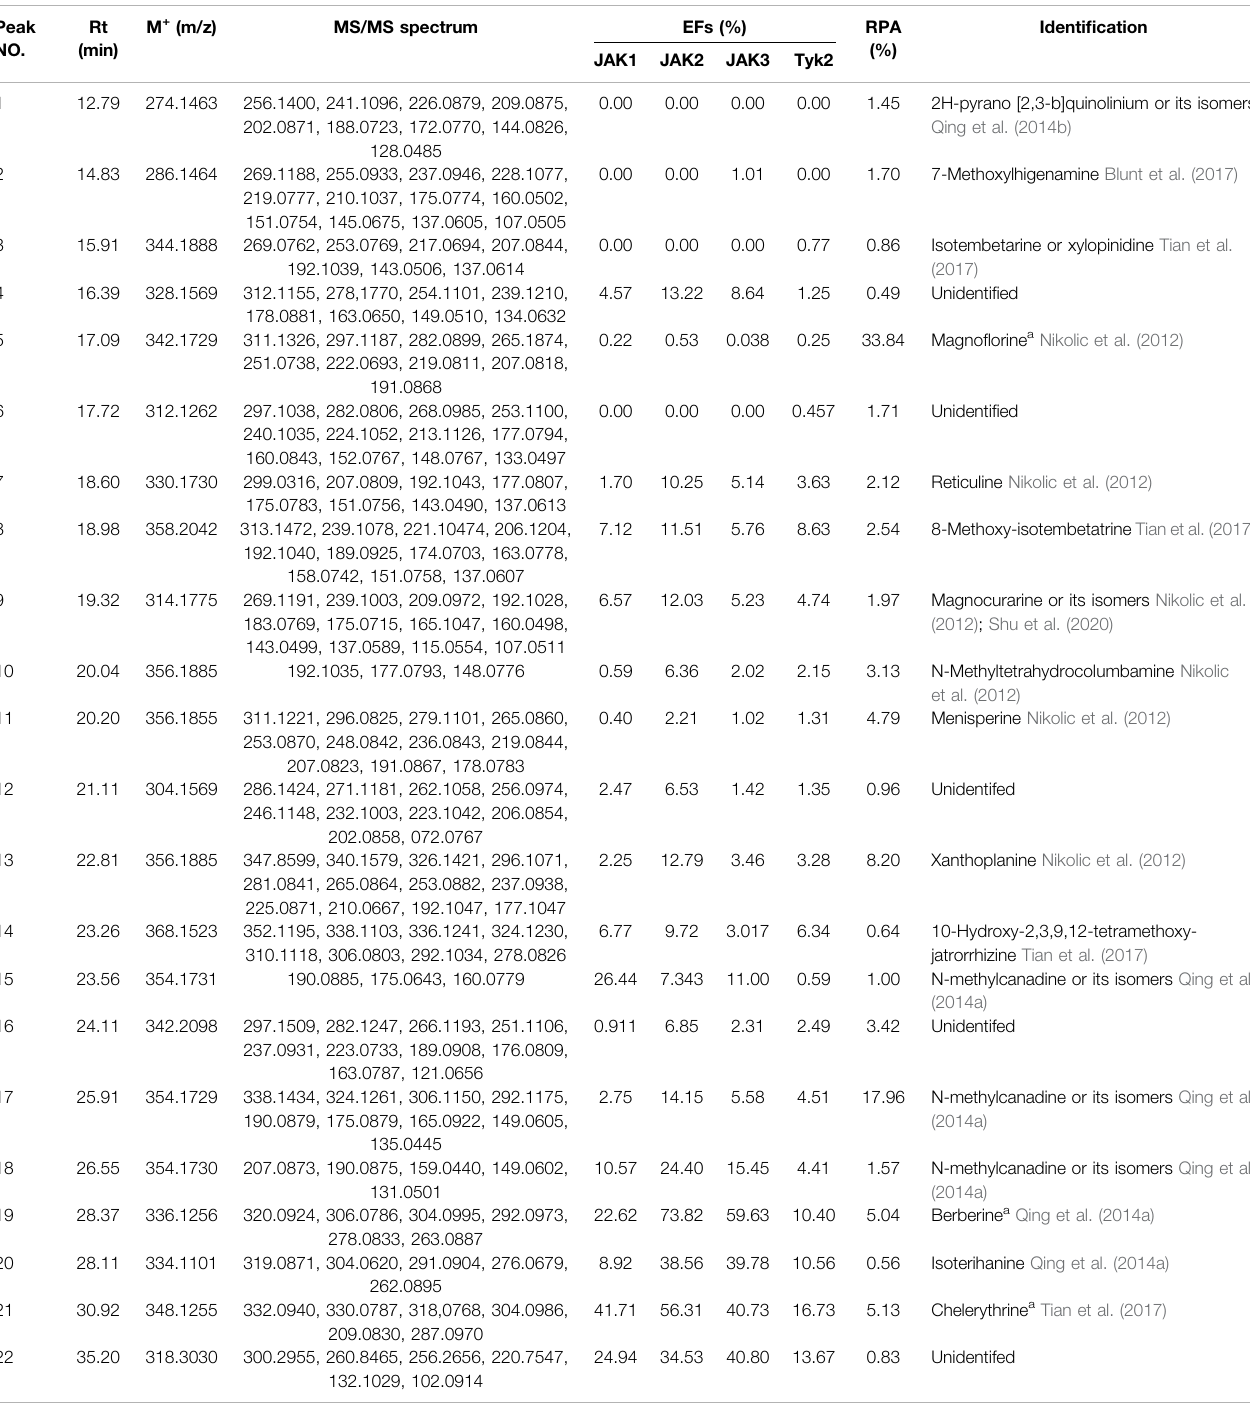
TABLE 1 | The EFs, RPA ,and identi fi cation of the potential ligands for JAKs in QAs. Peak